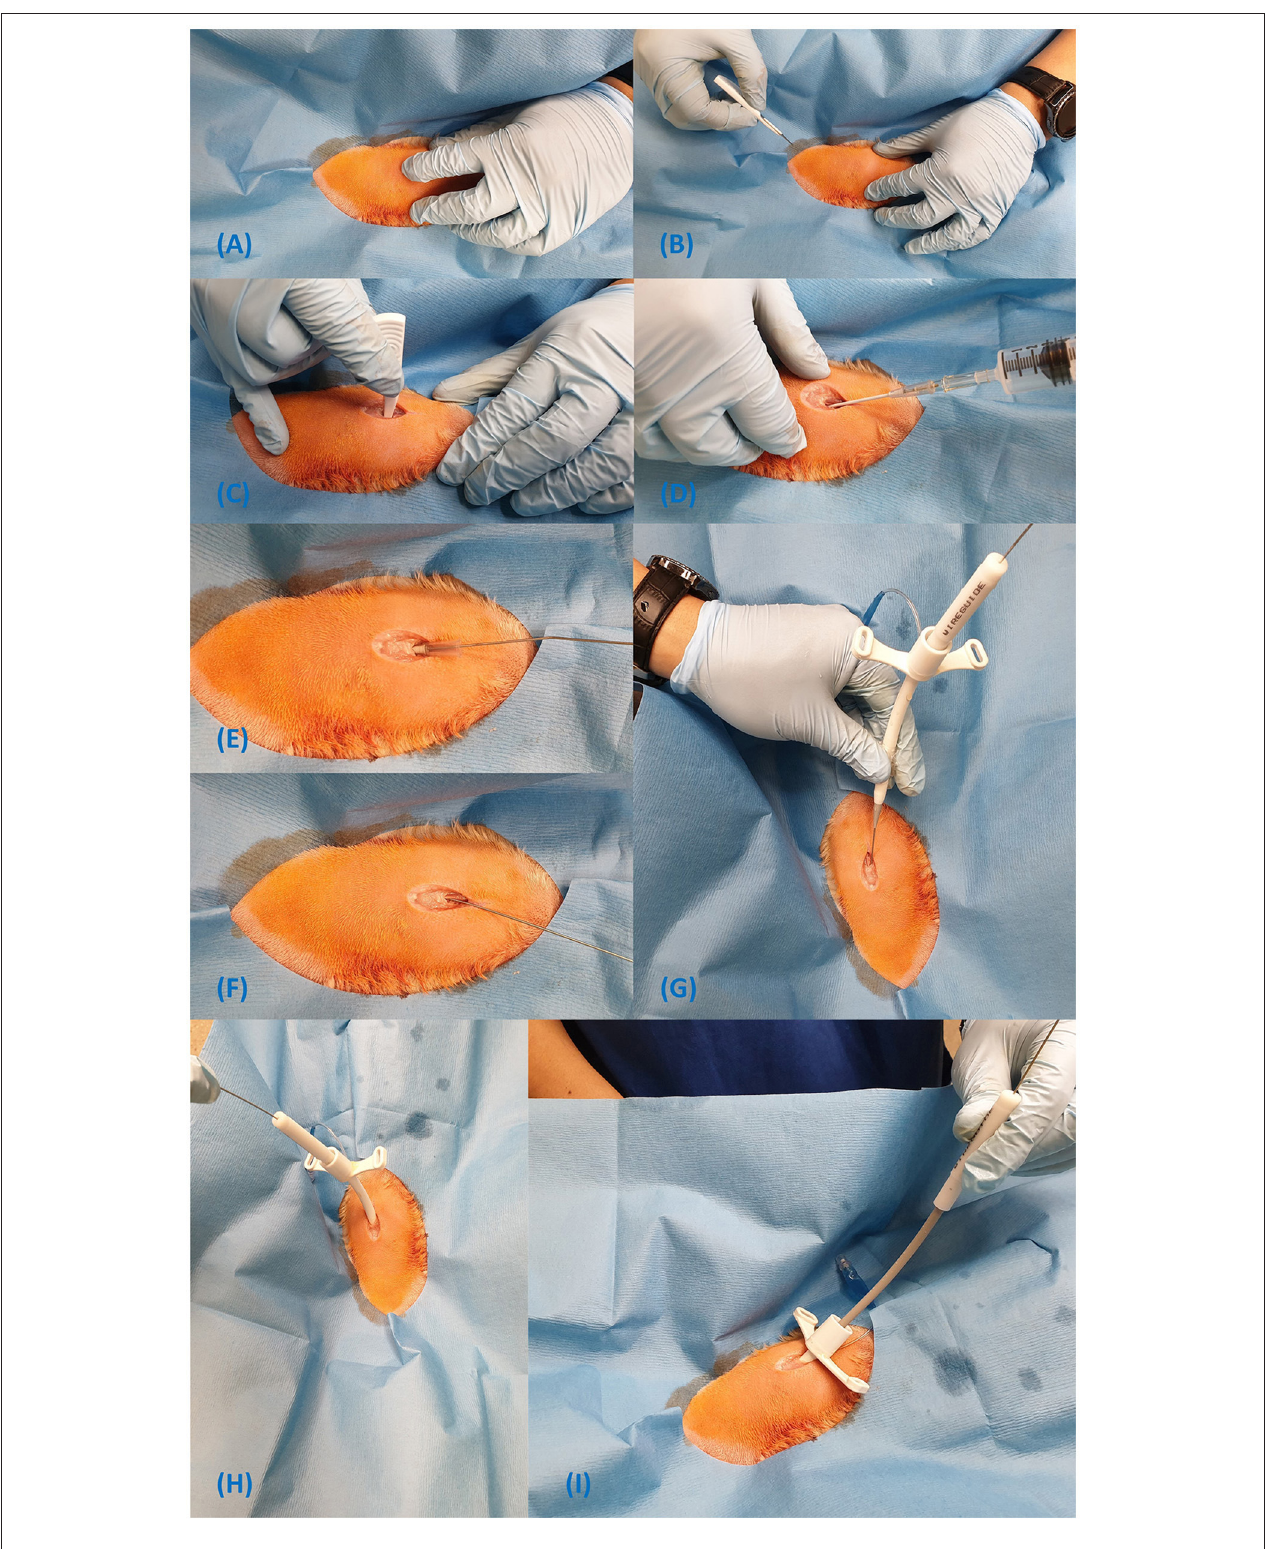
FIGURE 6 | Steps for insertion of the Melker cricothyrotomy tube using the Seldinger technique (A–I) .